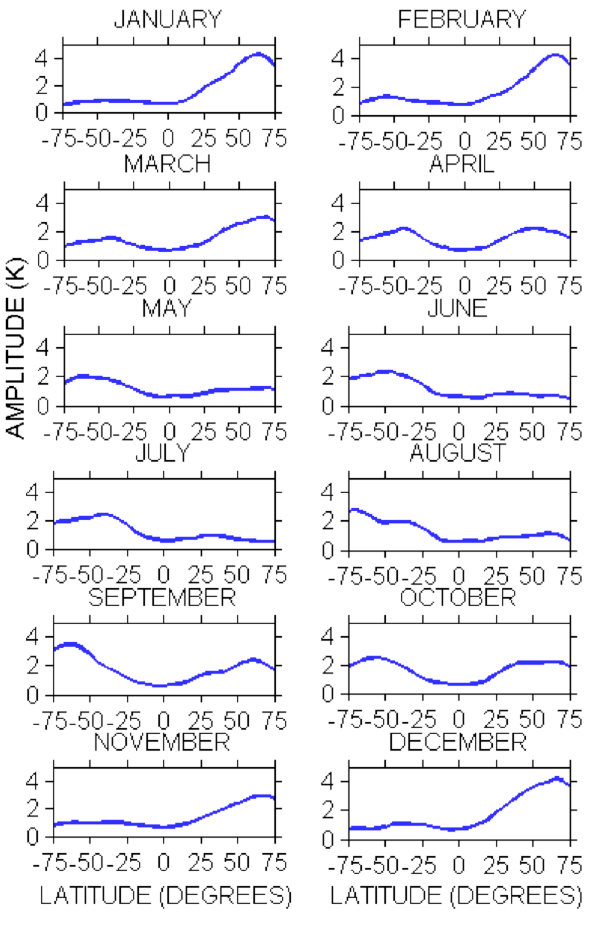
Fig. 5. The monthly-mean temperature amplitude of the 16-day wave as a function of latitude at heights of ∼ 65–95km for